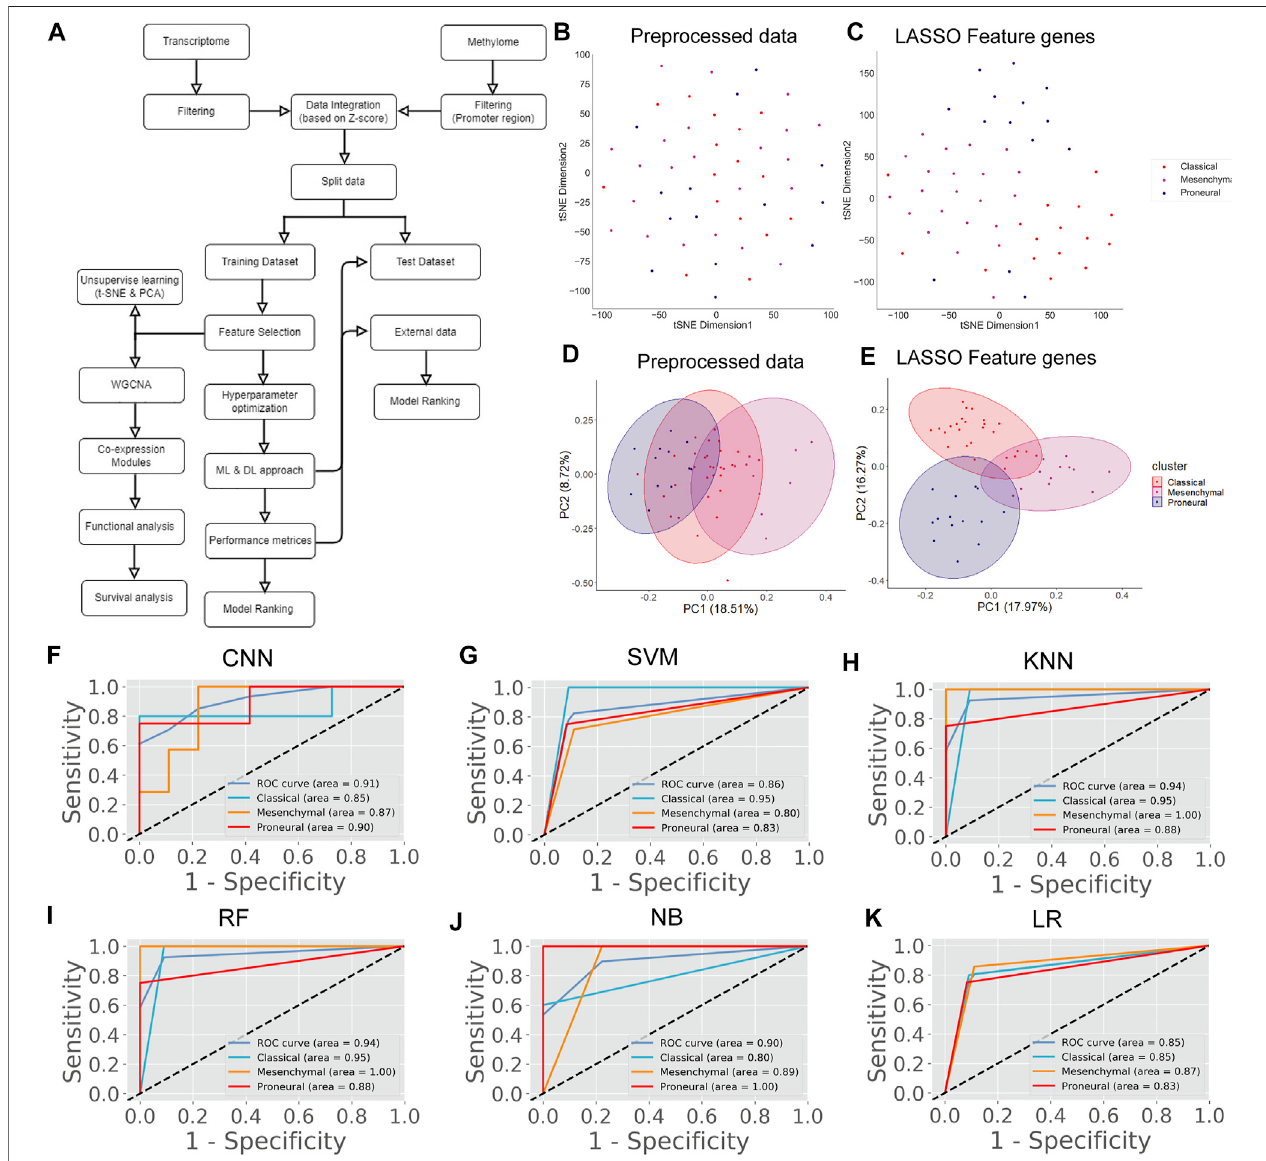
FIGURE 3 | GBM subtype classi fi cation using integrated data. (A) The fl ow chart shows DL and ML pipelines using the integrated data of transcriptome and methylometoclassifythesubtypes. (B,C) t-SNEplotstovisualizethesubtype-speci fi cclusteringofpatientfromfeaturesgene. (D,E) PCAplotstovisualizethesubtype- speci fi c clustering of patient from features gene. (F – K) ROC of various prediction models. ROC plots were generated using the test data